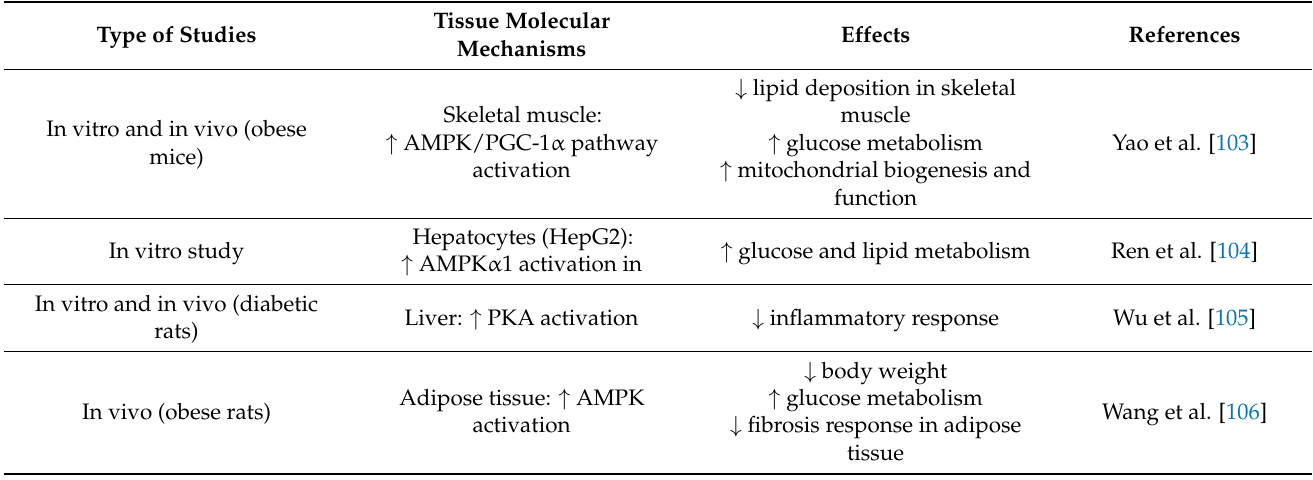
Table 1. Berberine as a CR-related nutrient ( ↑ increase/improvement, ↓ decrease/worsening). Tissue Molecular Type of Studies